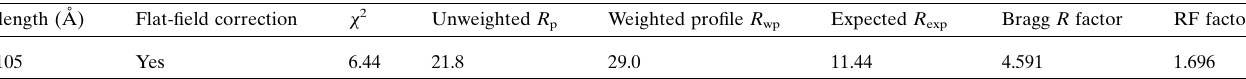
Table 4 Parameters used for the structure refined calculation.